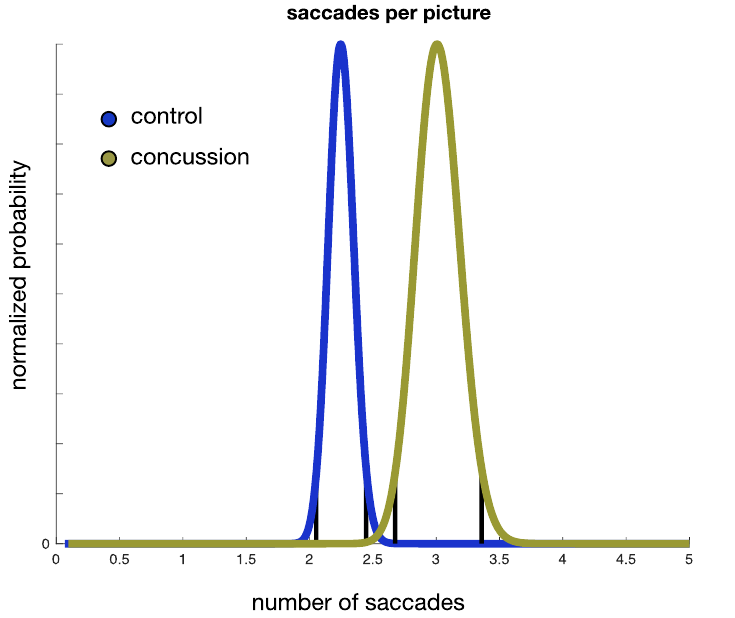
Figure 3. Posterior probability distributions and confidence intervals for the rate of saccades per picture in each group.